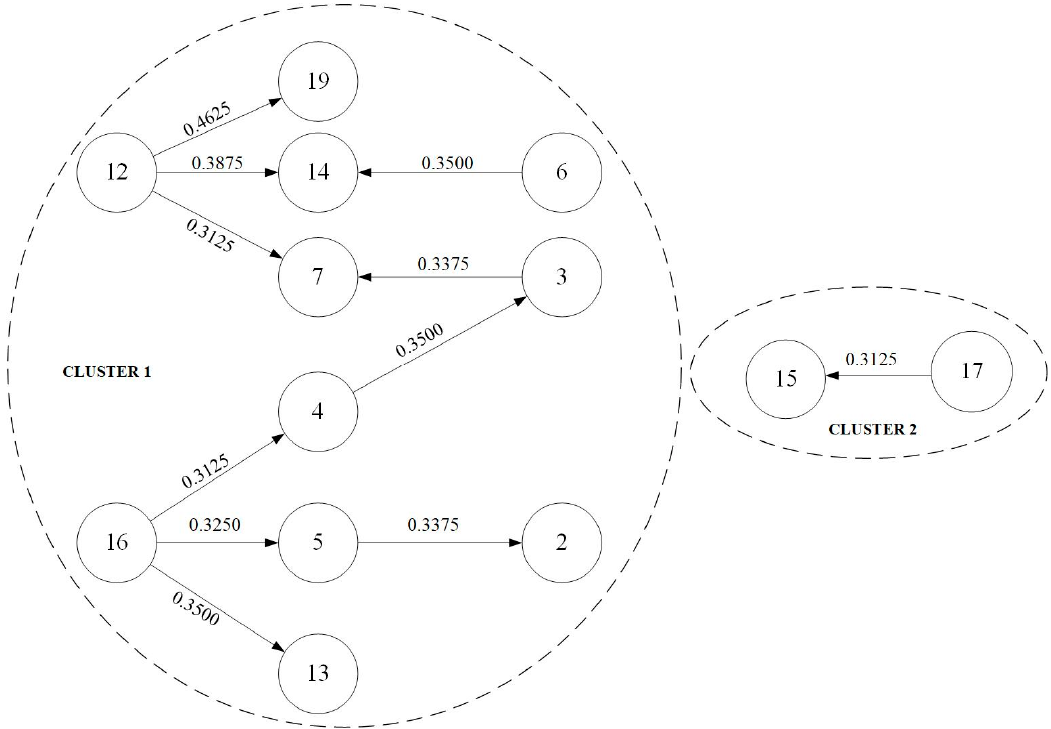
Figure 2. Fuzzy cognitive map.